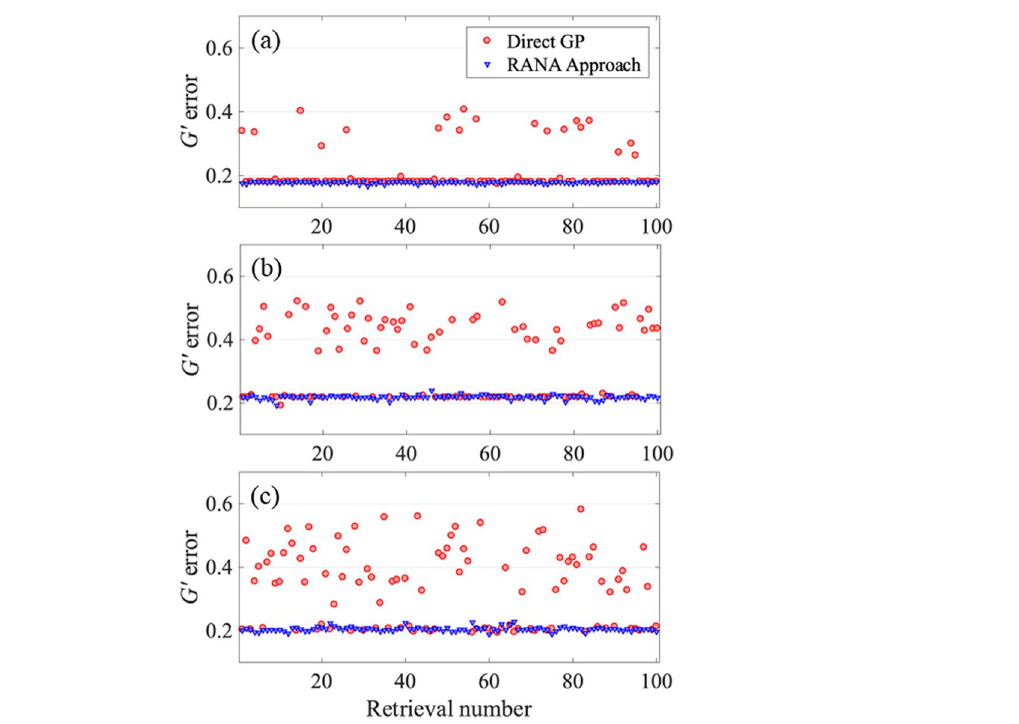
Figure 3. G ′ errors for retrieval of three noise-free traces corresponding to three unstable trains with average temporal FWHM of 26 fs ( a ), 54 fs ( b ), and 108 fs ( c ). The G ′ errors are obtained from the recovery of the pulse for 100 runs using the RANA approach and standard GP algorithm. Note that the RANA approach reliably yields the minimum G ′ error, while the GP algorithm alone does not, and additional runs of the algorithm are